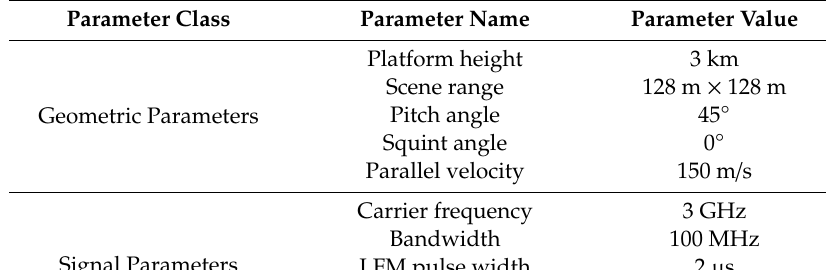
Table 4. Average running time of different algorithms (second). Table 5. Main parameters for range-azimuth imaging simulations.